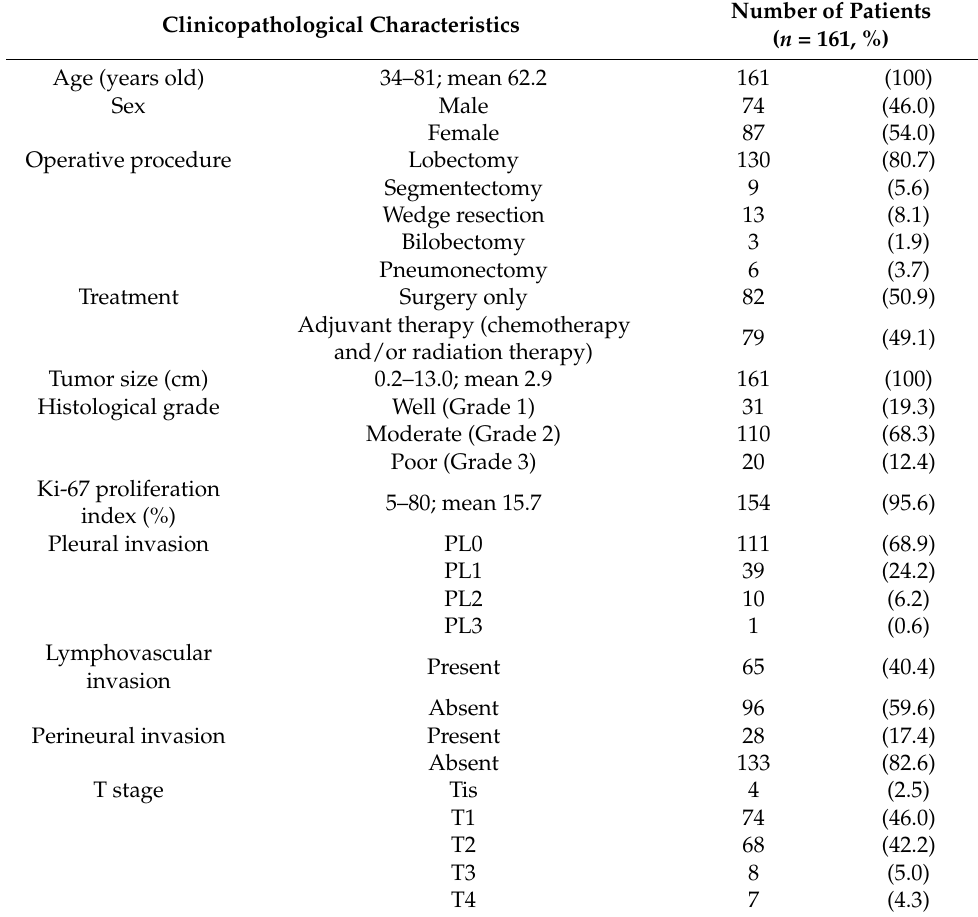
Table 1. Clinicopathological characteristics of the studied lung adenocarcinoma